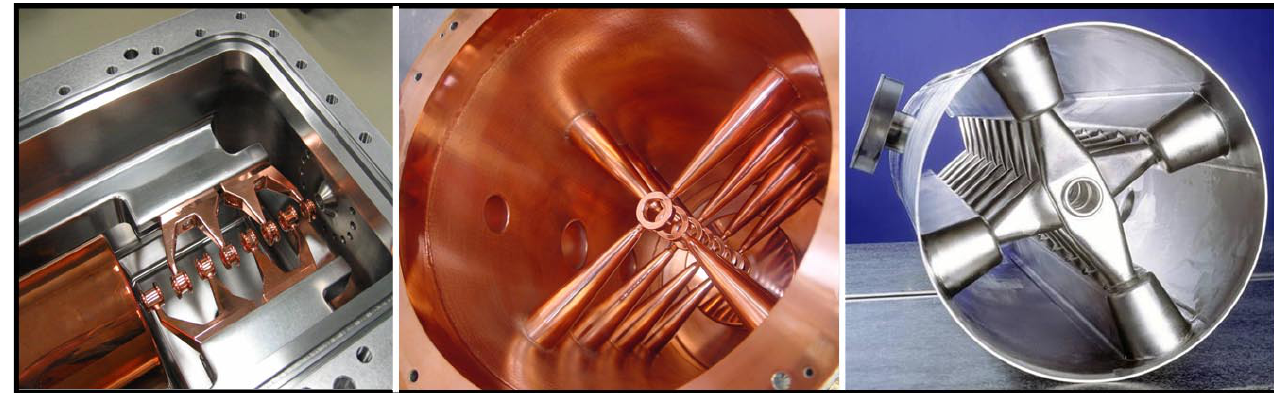
FIG. 2. (Color) H-mode drift-tube cavities: rt IH-DTL (217 MHz, left), rt CH-DTL (350 MHz, center) and sc CH-DTL (350 MHz,